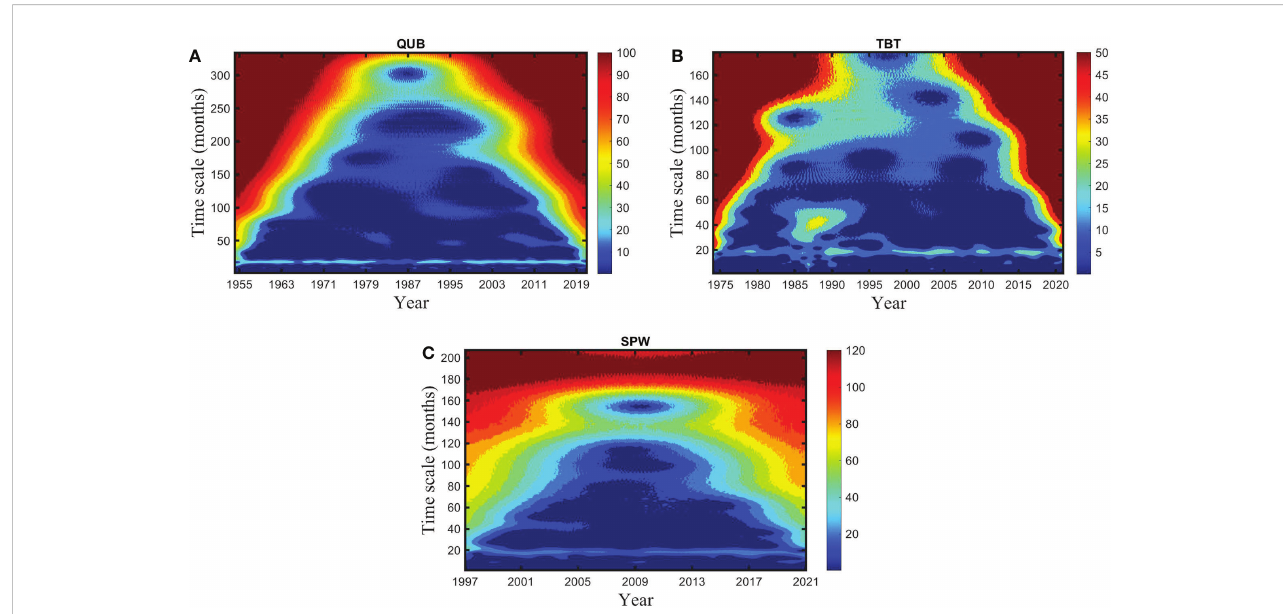
FIGURE 4 Modulus of the wavelet coef fi cient. (A – C) are the modulus of the wavelet coef fi cient at the QUB, TBT, and SPW tide gauge stations, respectively.